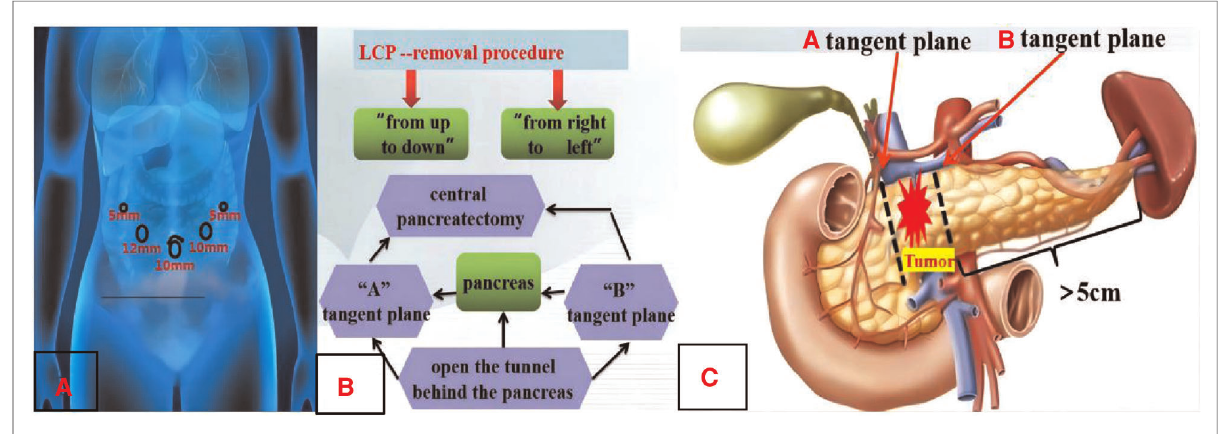
FIGURE 2 Preoperative design. A : Layout of “ 5 trocar-puncture ” . B : LCP-removal procedure. C : Schematic diagram of CP pancreatic